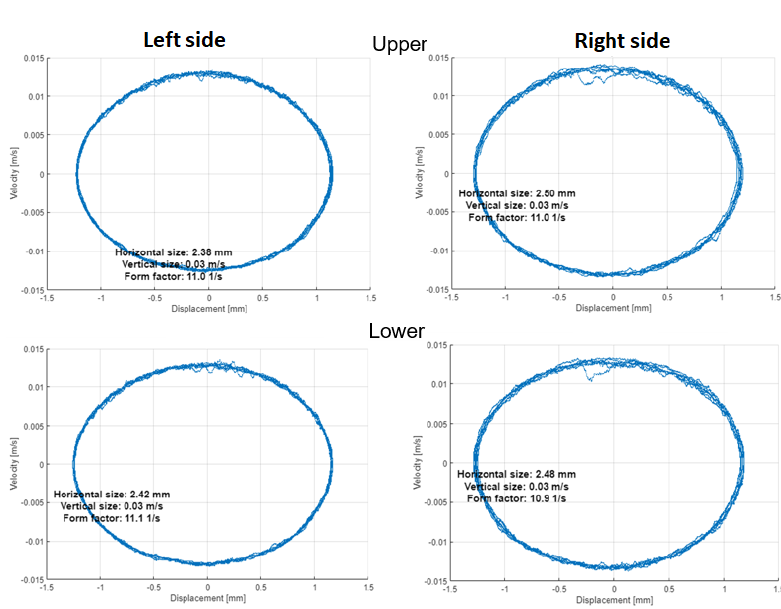
Figure 17. Phase space plots (PSP) after